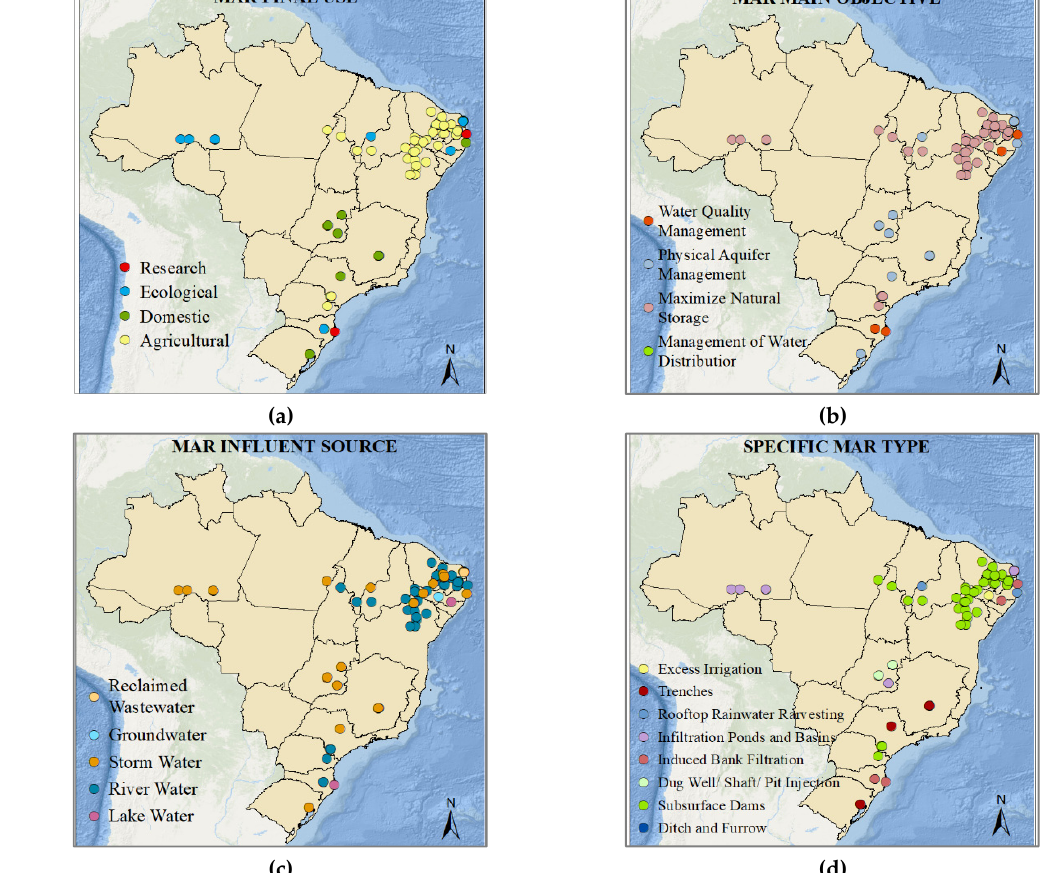
Figure 2. Localization of managed aquifer recharge (MAR) solutions in Brazil, sorted by ( a ) MAR final use; ( b ) MAR main objective; ( c ) MAR influent source; ( d ) Specific MAR type. Source: Adapted from